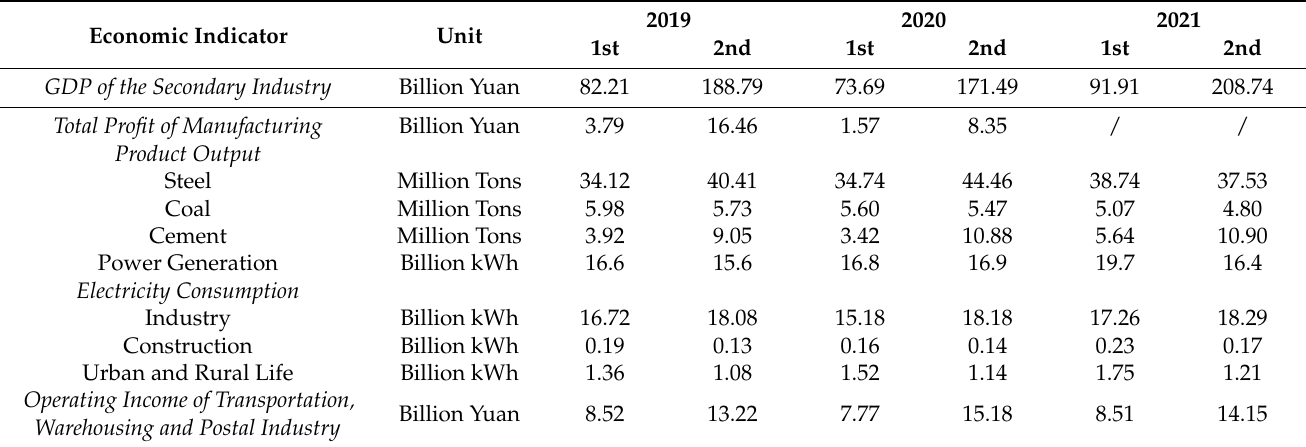
Table 1. Main economic indicators for the city of Tangshan in the first and second quarters of the 2019–2021